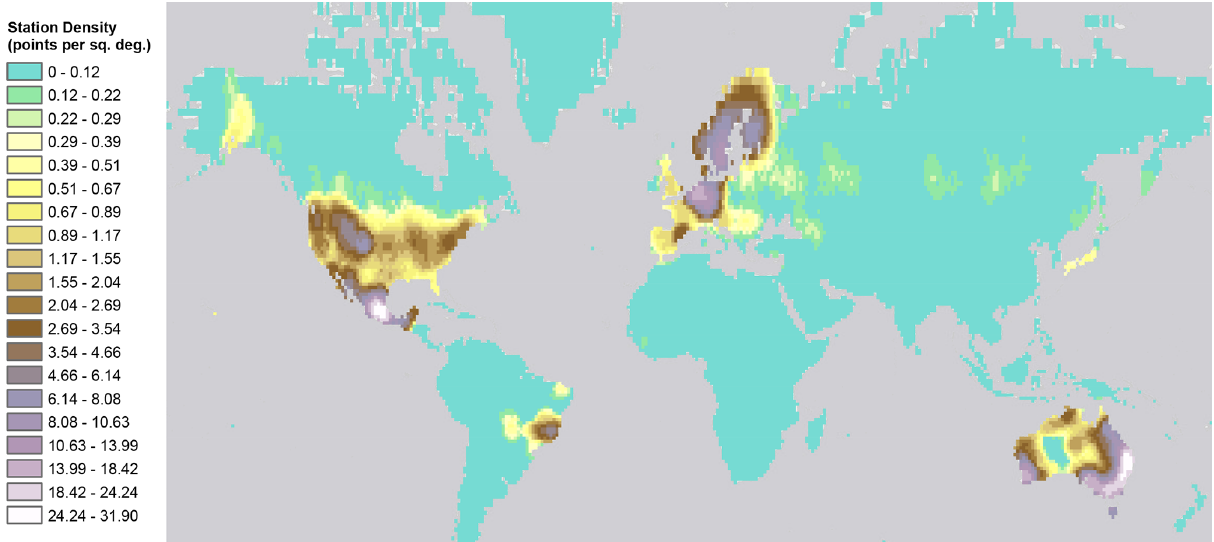
Figure 2. Station density map representing all stations combined. The cell size is defined by lat–long degree lines (1 ◦ × 1 ◦ ). Densities are calculated inside of circular neighborhoods with radii of 3 ◦ from the center of each cell. Table 2. A list of CLIGEN input parameters determined for each station. The temporal resolution column indicates the resolution of the data used to derive each parameter. Parameters that require sub-daily resolutions at various frequencies of measurement are denoted with “High-res” in the temporal resolution column. Sub-daily resolution data were not available for High-res. parameters, and it is discussed how their values were